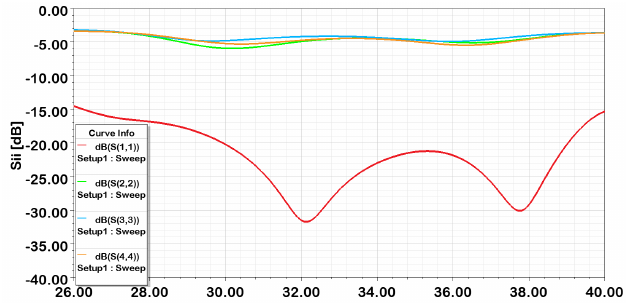
FIGURE 14. Matching on all the four ports of the system with a triple P-QWT.